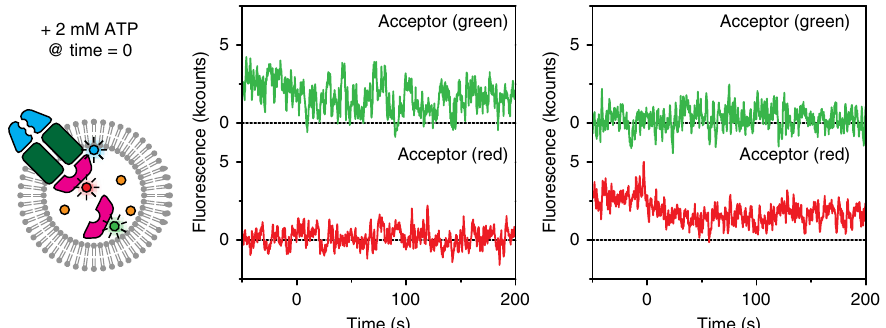
Fig. 3 Absence of exchange observed with FRET. BtuCD cys labelled with Alexa Fluor 488 was reconstituted in liposomes loaded with 50% BtuF labelled with Alexa Fluor 555 (acceptor, green), 50% BtuF labelled with Alexa Fluor 647 (acceptor, red), and 100 µ M vitamin B 12 . One example of an initially bound ‘ green ’ BtuF (middle panel) and one of an initially bound ‘ red ’ BtuF (right panel) are displayed. While ATP and Mg 2+ were present, no increase in fl uorescence intensity in the opposite channel (red or green respectively)